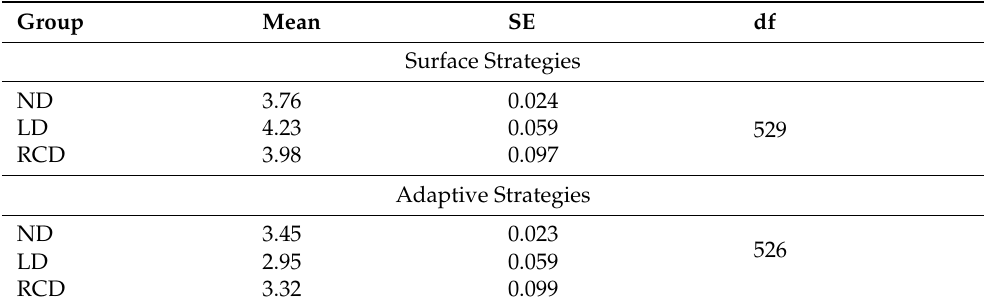
Table 7. Descriptives of Surface and Adaptive Strategies based on final models.